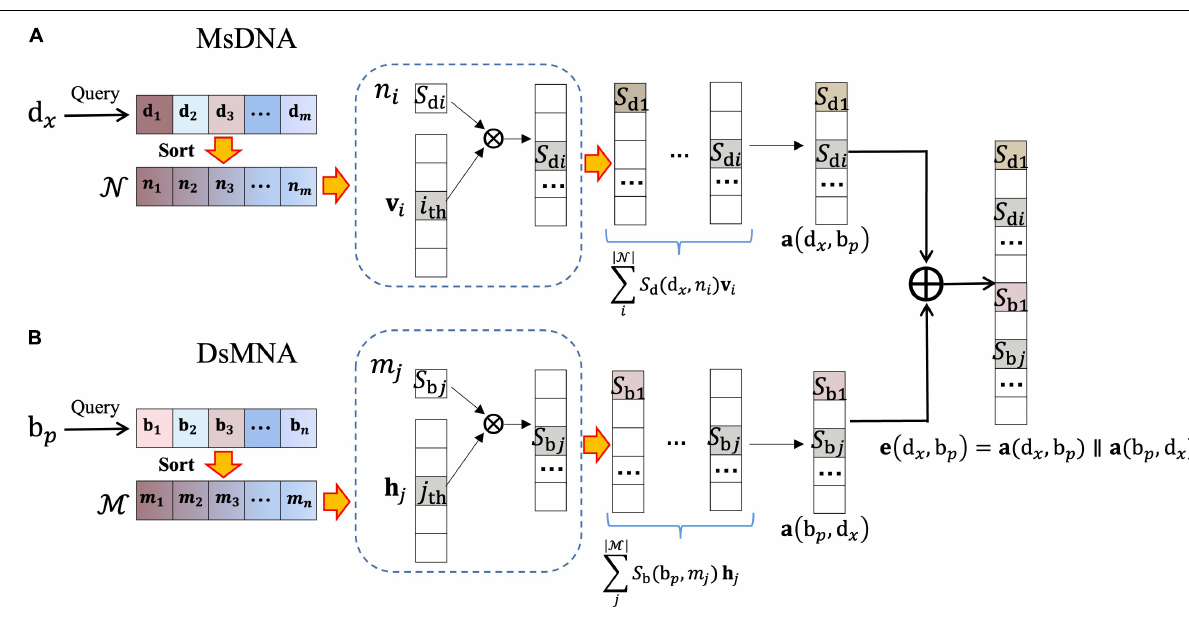
FIGURE 2 | Nearest-Neighbor Aggregator block. (A) Microbe-specific drug neighbor aggregator (MsDNA); the embedding representation of the unidirectional edge, which is from the drug d x to the microbe b p . (B) Drug-specific microbe neighbor aggregator (DsMNA); the embedding representation of the unidirectional edge, which is from the microbe b p to the drug d x , where x ⊆ is a set of instantiated keywords, x denotes the neighbors of microbe b p in the Net b . S b ( b p , m j ) denotes the similarity of b p and m j . h j is the corresponding one-hot encoding vector of m j